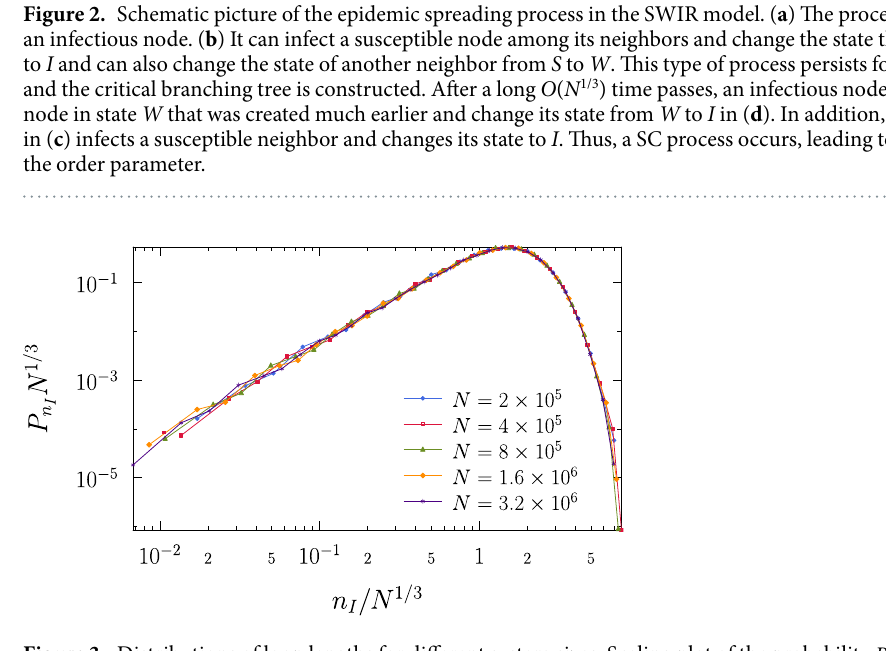
of the n I 1/3 as a function of n I / N 1/3 . Data n I